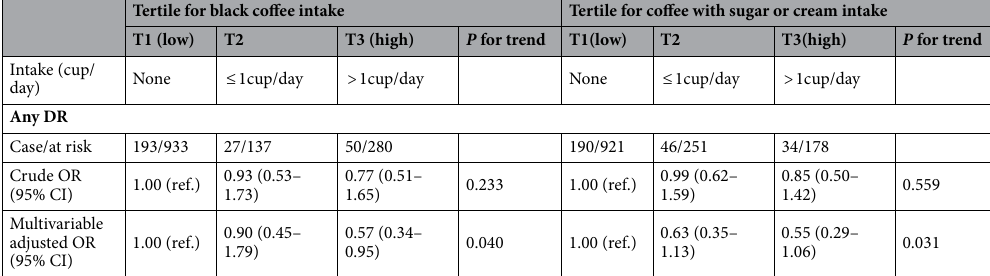
Table 3. DR according to the tertiles of coffee intake consumed from one-day 24-h dietary recall among patients with type 2 diabetes (n = 1350). Multivariable adjustments included age, gender, education, occupation, income, body mass index, energy intake, hypertension, dyslipidemia, duration of diabetes, glycated hemoglobin (%), smoking, drinking, and physical activity (aerobic, moderate, walking level). DR, diabetic retinopathy; the black coffee intake group and coffee with sugar or cream intake group were mutually adjusted; OR, odds ratio; CI, confidence